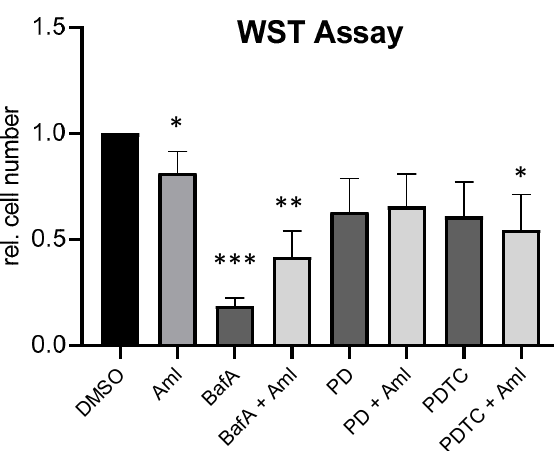
Figure 7. Cell proliferation of SK-Mel-28 cells treated with amlexanox with and without combination with inhibitors for autophagy (bafilomycin A (BafA)), p42 / 44 (PD98059 (PD) and NF- к B (pyrrolidine dithiocarbamate (PDTC) as assessed by the WST assay. ( n = 3), * p < 0.05, ** p < 0.01, *** p < 0.001 in comparison to the vehicle-treated control cells.